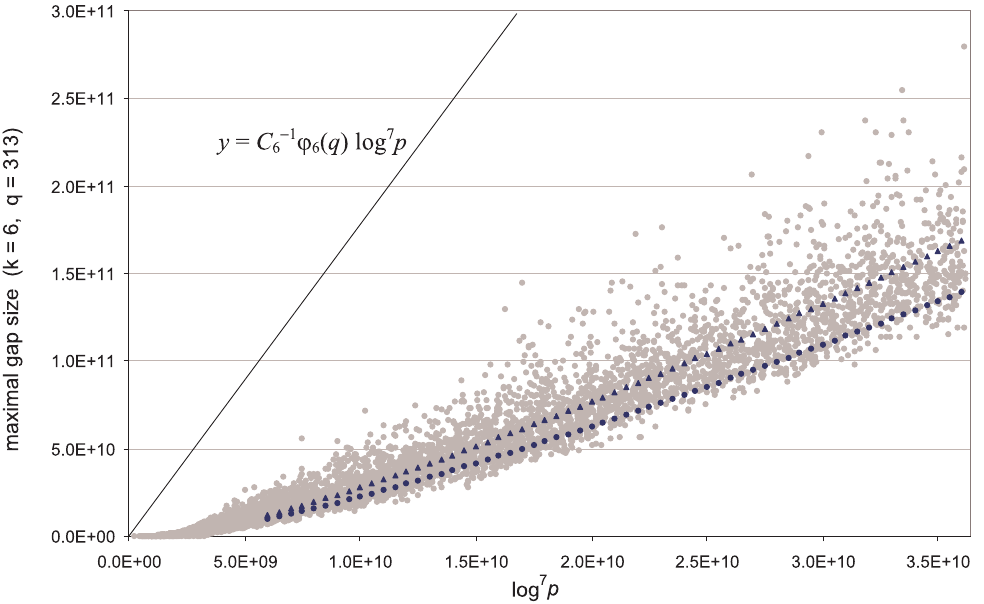
Figure 3. Maximal gaps G c between prime sextuplets p = r + nq ∈ P c below x for q = 313, x < 10 14 , k = 6. Dotted curves: trends T c ( • ) and ¯ T c ( (cid:78) ) of Equations(12) and (14); top line: y = C − 1